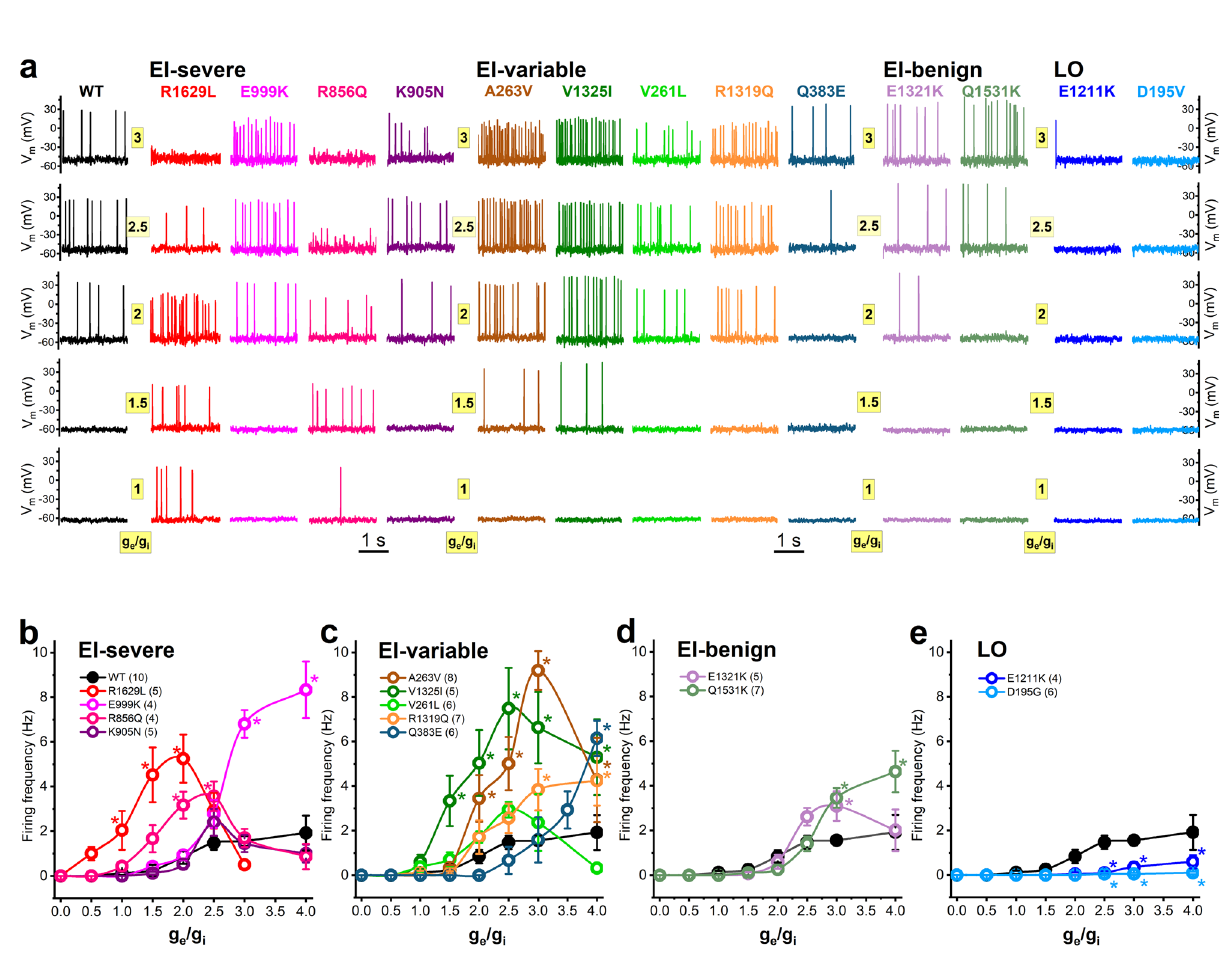
Fig. 4 Action potential fi ring of the axon initial segment hybrid neuron incorporating Na v 1.2 variants in response to synaptic conductance input in DAPC experiments. a Representative action potential fi ring elicited with g e / g i ratios of 1, 1.5, 2, 2.5, and 3 in the early-infantile (EI)-severe, EI-variable, EI- benign and later-onset (LO) groups. b – e Input – output relationships in the presence of Na v 1.2 channel variants (WT, black solid circle; mutants, colored open circles) associated with EI-severe ( b ), EI-variable ( c ), EI-benign ( d ), or later-onset (LO) ( e ) SCN2A epilepsy. Two-way ANOVA, followed by Dunnett ’ s post-hoc test, was used to compare the AP fi ring frequencies elicited by scaled excitatory to inhibitory conductance ratios ( g e / g i ) in the presence of Nav1.2 variants; asterisks indicate P < 0.05 (see individual P values in Supplementary Table 7). Note the increased fi ring activity in the early-infantile severe/ variable groups compared to wild-type, whereas later-onset variants result in an almost complete loss of fi ring. Data shown are mean ± SEM; n , the number of independent experiments between stimuli (Fig. 3b), further validating the unique fi ring pro fi les due We also tested the impacts of Na v 1.2 variants on hybrid neuron fi ring using scaled ratios of excitatory and inhibitory synaptic to distinct Na v 1.2 mutations. Taken together, in DAPC mode, all early-infantile conductances ( g e / g i ), as this is a more biologically realistic synaptic current stimulus than the step stimulus trialed above 23 . phenotype variants except K905N resulted in GoF and both later-onset phenotype variants produced LoF. Thus, DAPC reliably predicted phenotypic group for all but one variant. However, it could not differentiate benign from severe early- relationships (Fig. 4b), were similar to those elicited by step infantile phenotypes.